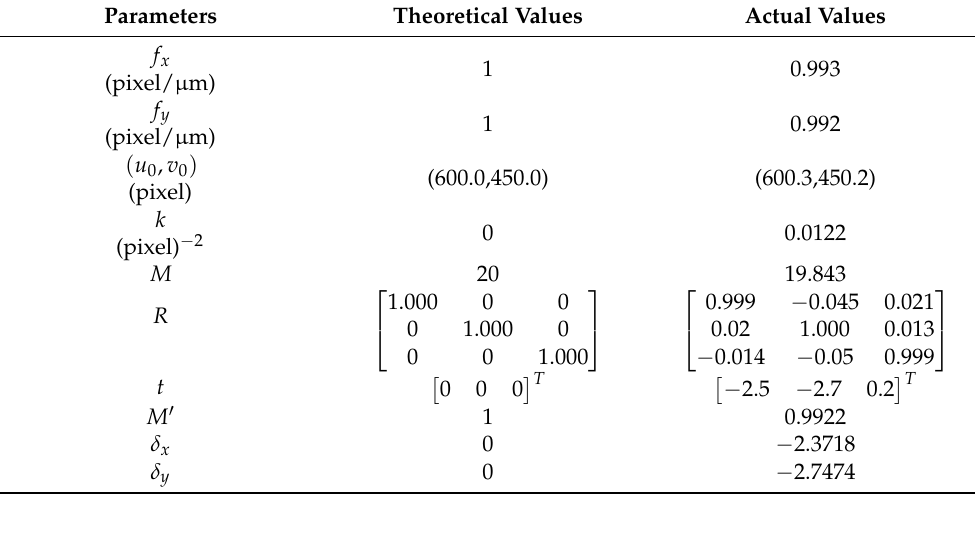
Table 1. Results of error compensation coefficient M , δ x δ y .